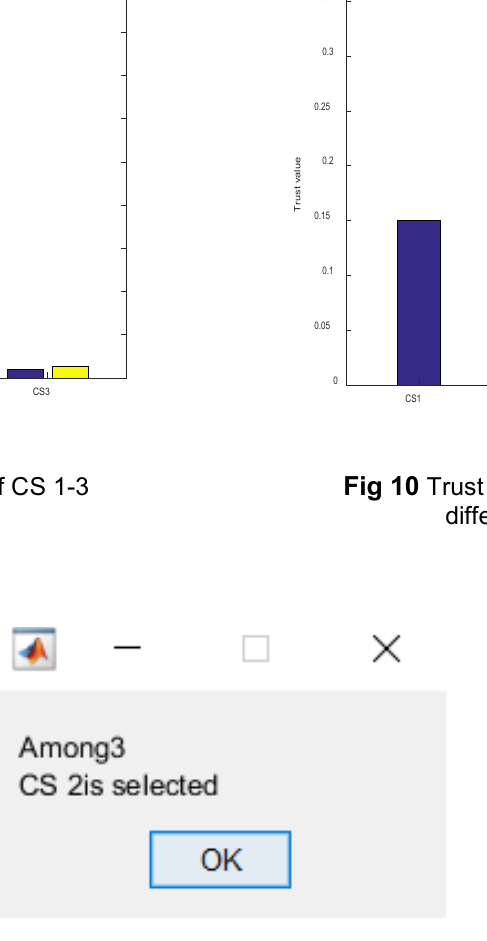
Fig 11 CS2 selection